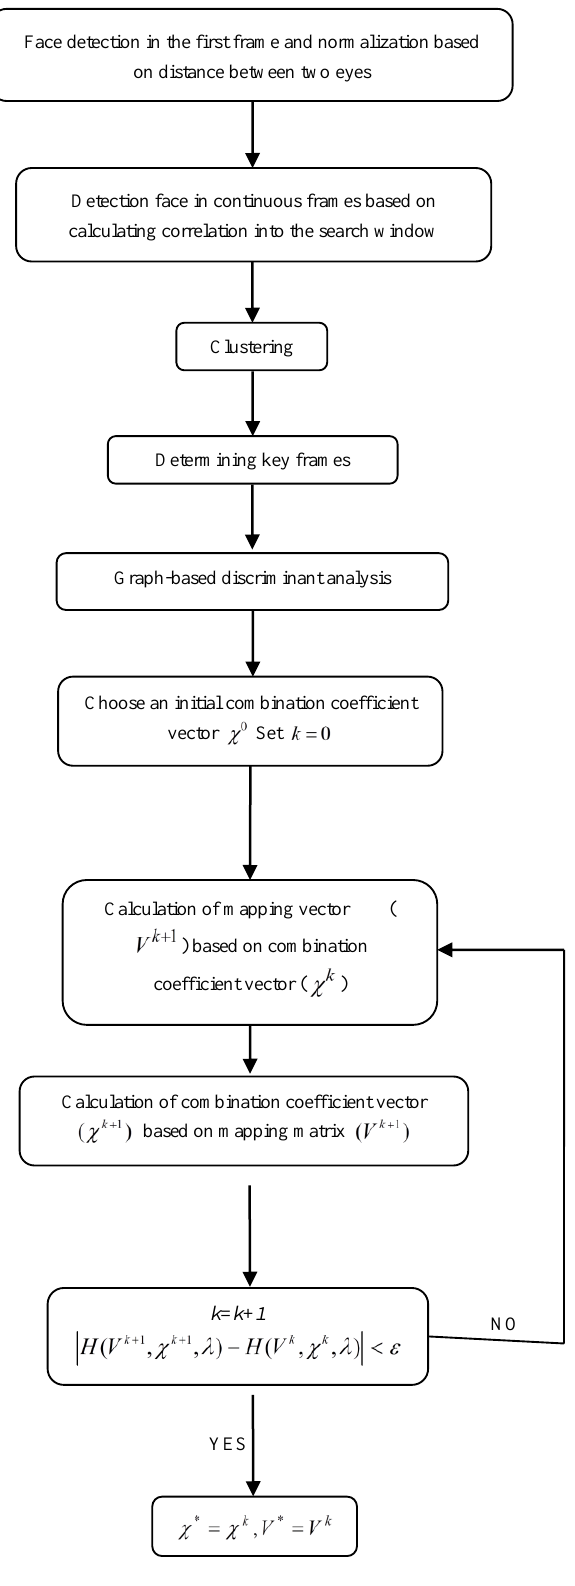
Figure 1. The block diagram of the proposed